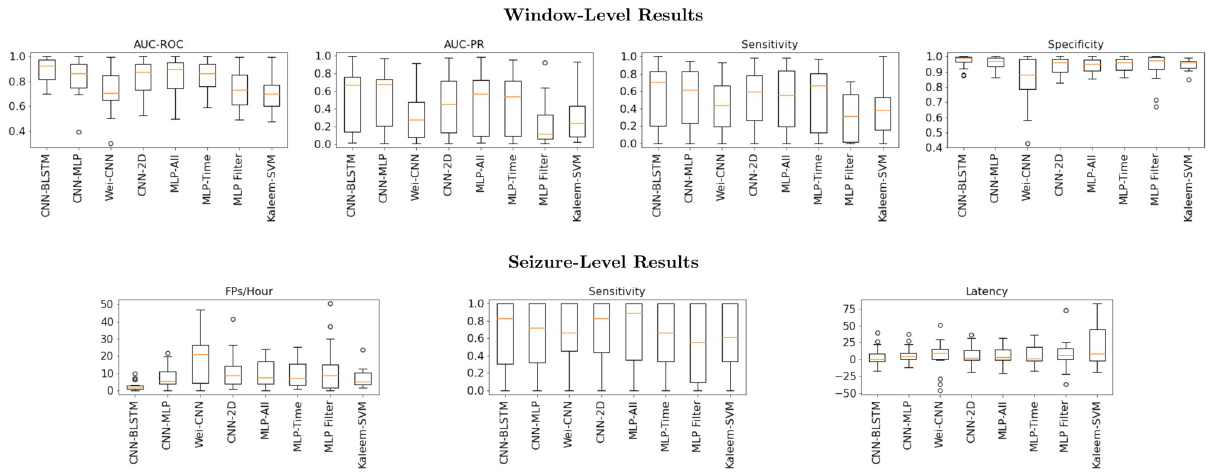
Fig 6. Seizure detection performance on the UWM dataset. Box plots capture the average performance for each metric across the 16 patients. The orange bar denotes the median performance, boxes correspond to the inter-quartile range, and the whiskers denote the 10th and 90th percentiles. Top : Window level results are calculated on one-second windows of EEG. Bottom : Seizure level results are calculated over the duration of the seizure period.